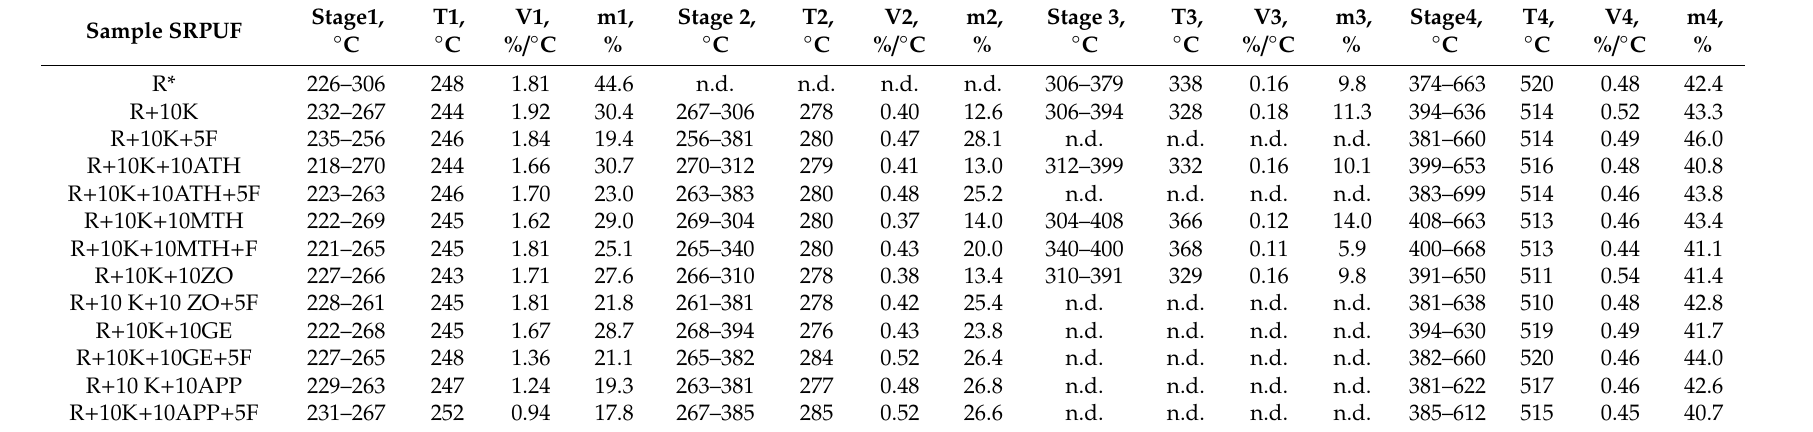
Table 6. Results of DTG curves analysis obtained by TGA measurements carried out in air